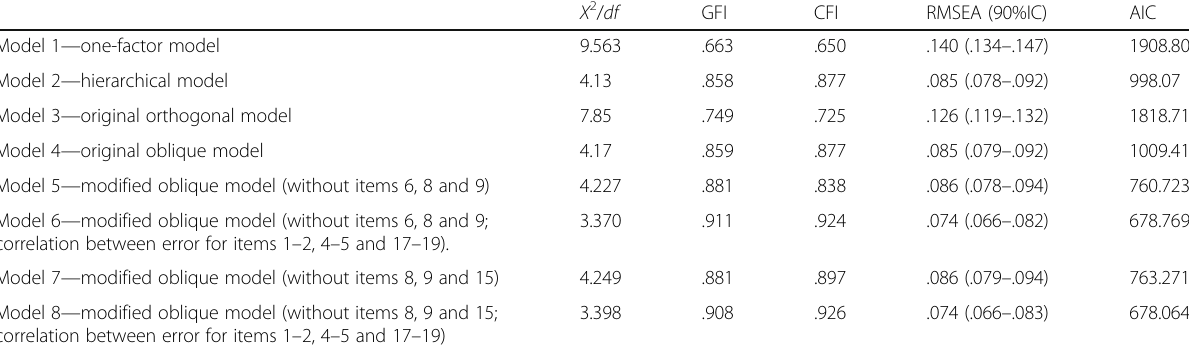
Table 2 Absolute goodness-of-fit indices for eight CFA models of the SWBQ b in the Brazilian calibration sample ( N = 436) X 2 / df GFI CFI RMSEA